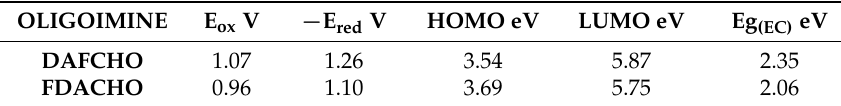
(b) Figure 7. Simulated UV-Vis spectra of DAFCHO ( a ) and FDACHO ( b ) calculated at the TD-M062x/cc- pVTZ level of theory with PCM parameters for chloroform using FWHM (Full Width at Half Maximum) of 3000. Individual excitations are displayed as vertical lines with heights representing their oscillator strengths. For DAFCHO the most intense excitation is observed around 394 nm and is related to the HOMO → LUMO+2 transition, whose contribution to the first excited state is around 51%, while the HOMO−1 → LUMO transition contribute another 13% (see Table 3). For FDACHO the most intense excitation